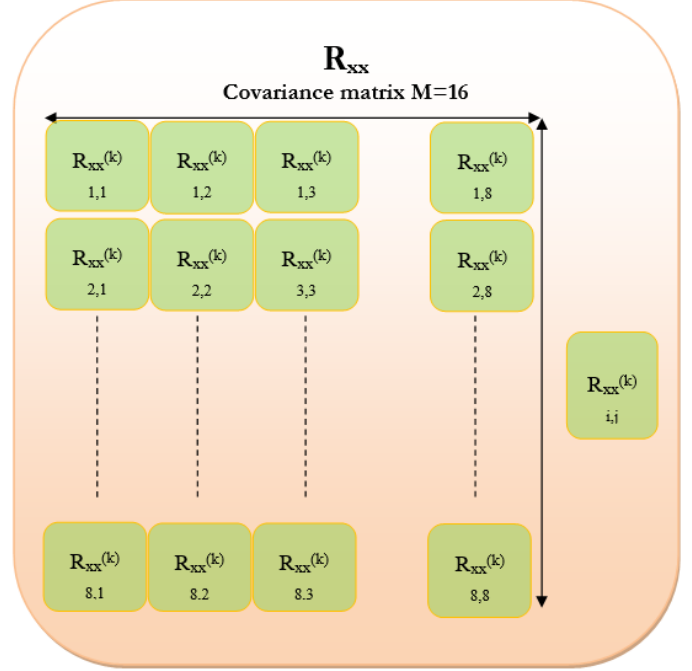
Figure 5. Covariance matrix M =